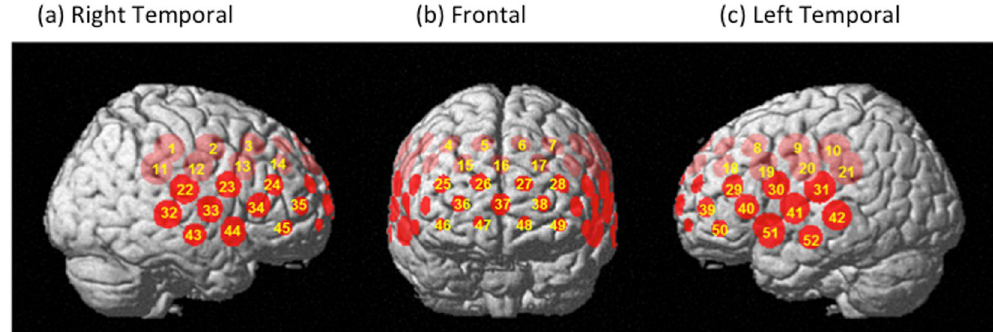
Figure 2. Measurement points of 52 channels for near-infrared spectroscopy. The measuring positions of the device are superimposed on the 3D-reconstructed cerebral surface, based on magnetic resonance imaging, in the right temporal ( a ), frontal ( b ), and left temporal ( c ) brain regions. The 52 measuring positions are labeled channel (ch) 1 to 52, from the right posterior to the left